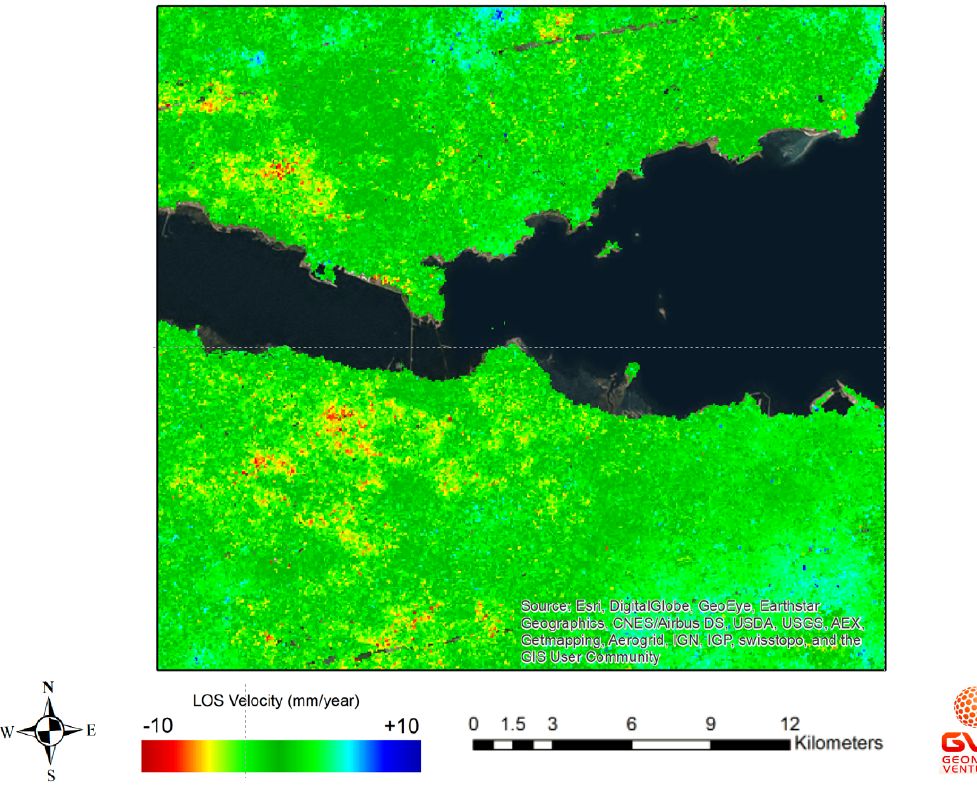
Figure 24. InSAR image processing of the area around the FRB, Scotland (October 2017).